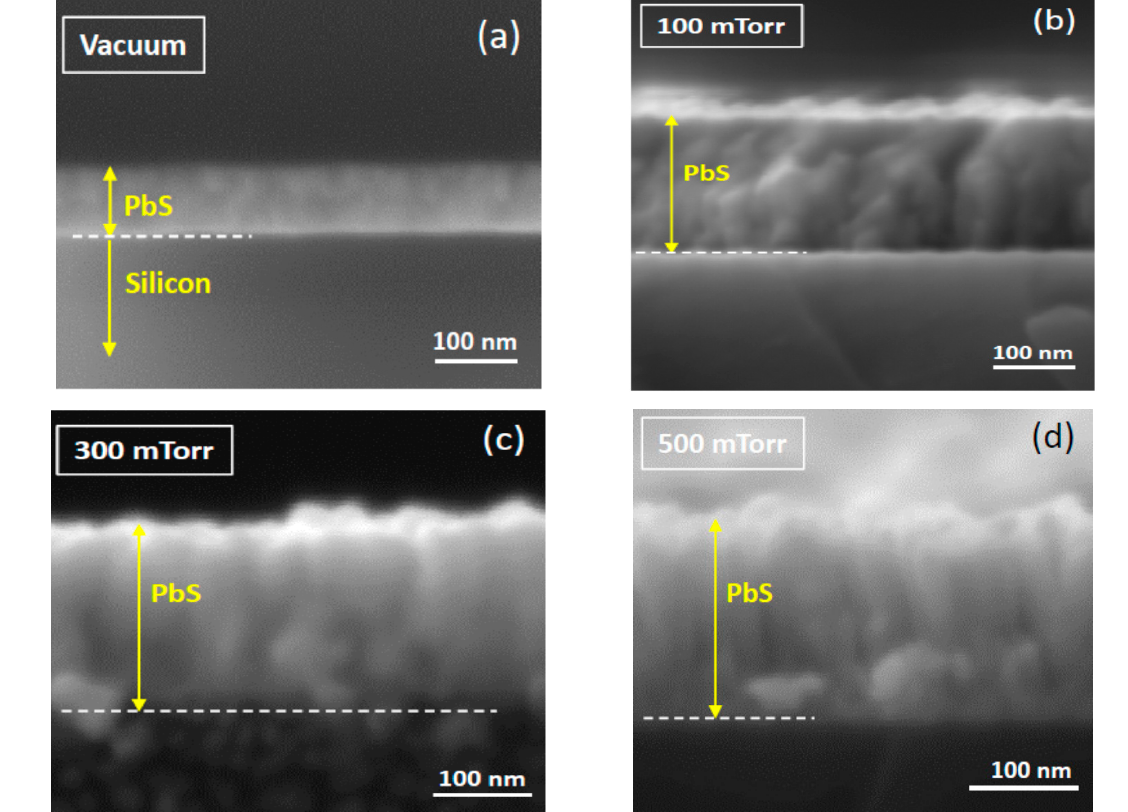
Figure 2. Typical SEM images of the PbS films deposited at N LP = 3500, under vacuum ( a ) and ( b – d ) different He background pressures.